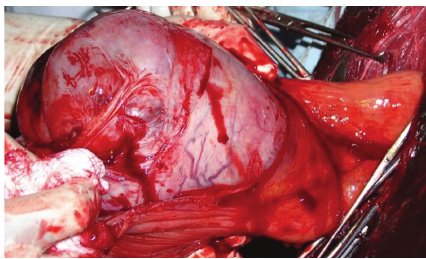
Figure 3: Hysterotomy depicting the intraluminal location of the mass in the right uterine